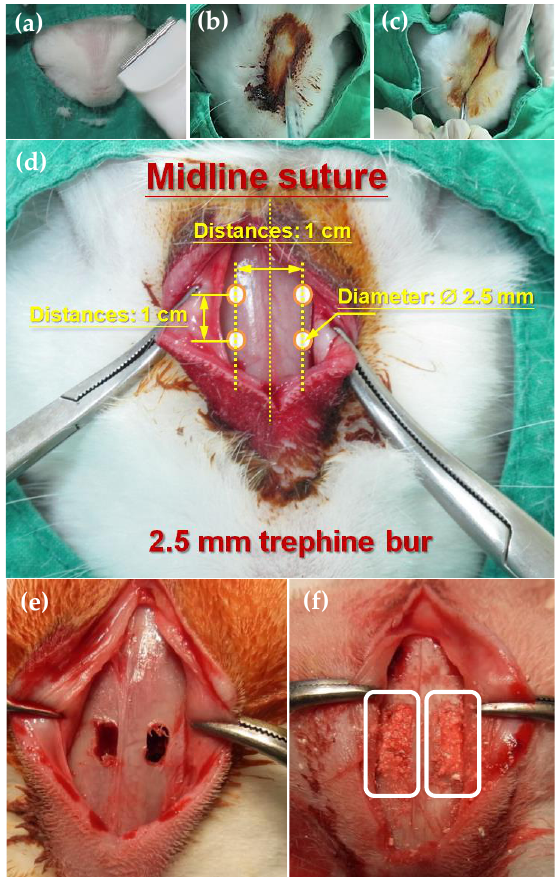
Figure 1. The implantation procedure on rabbit’s created-maxillary sinus: ( a ) fur shaving at nasal dorsum area, ( b ) local anesthesia injection, ( c ) periosteal incision, ( d ) circular window, ( e ) rectangular window, and ( f ) implantation of the investigated α -CSH/PRP and α -CSH bone graft samples (randomly).